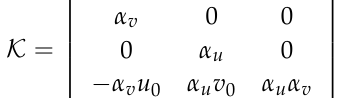
III. L ANDMARK INITIALIZATION Points are stacked as a 2-vector containing Cartesian coordinates in pixel space, and are modeled as a Gausian variable.